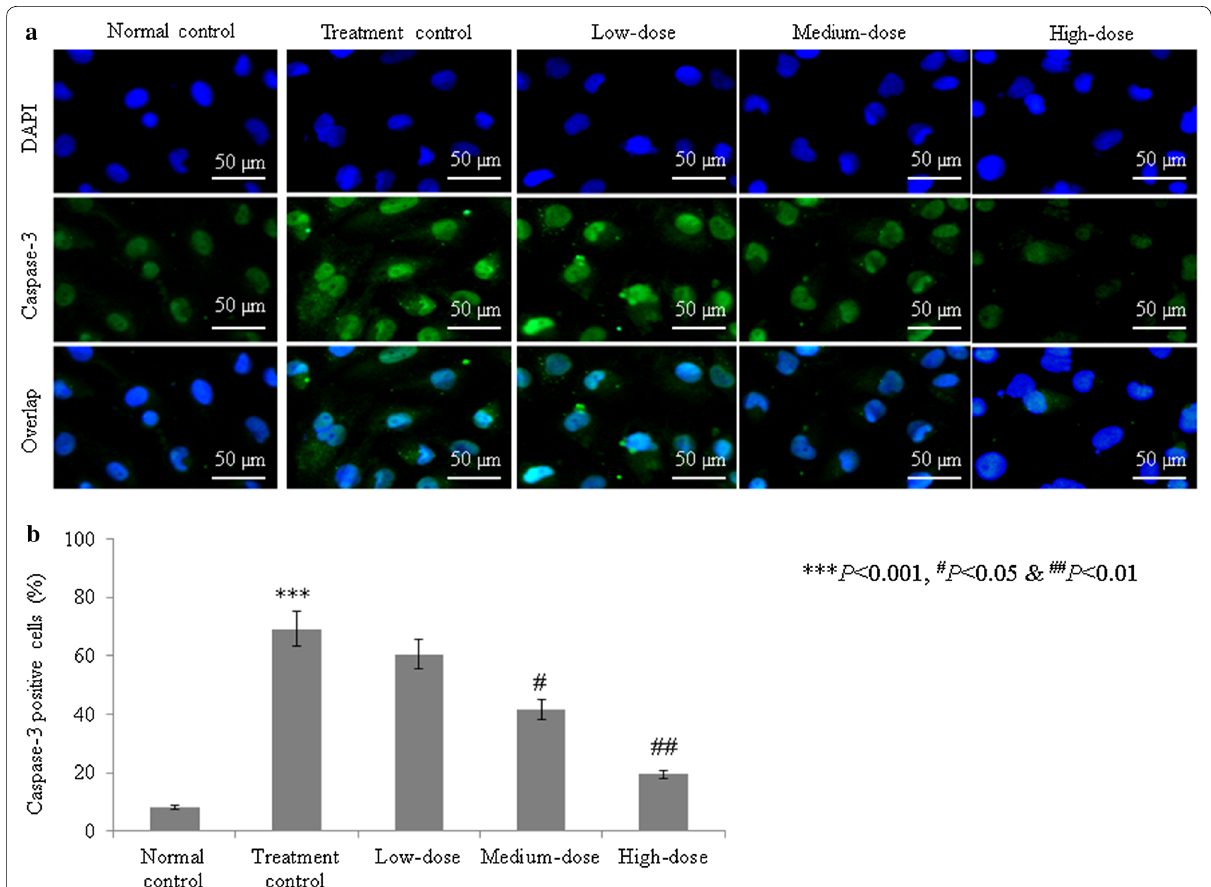
Fig. 5 Effect of catalpol on caspase-3 expression in human induced pluripotent stem cells with aconitine-induced cardiac arrhythmia. Catalpol treatment reduced the percentage of caspase-3-positive cells by 12.7, 39.9, and 71.82% at 1, 10, and 100 µM concentrations, respectively. a Immunofluorescent images of caspase-3-positive cells. b Percentage analysis of caspase-3-positive cells. *** P < 0.001 vs. Group I; # P < 0.05 and ### P < 0.001 vs. Group II. Scale bar is 50